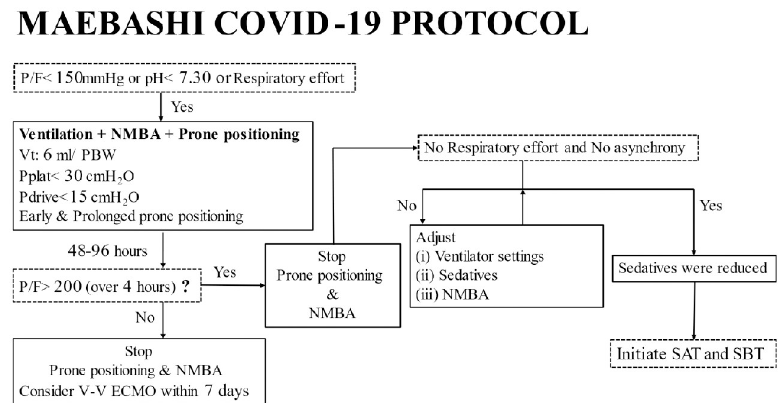
Fig 1. Maebashi COVID-19 protocol. MAEBASHI COVID-19 PROTOCOL (included the lung-protective strategy): Lung-protective ventilation with neuromuscular blocking agents, early application of prone positioning, and prolonged prone positioning. Abbreviations: P/F = PaO2/FIO2; PBW = predicted body weight; Vt = Tidal Volume (mL); Pplat = plateau airway pressure; NMBA = neuromuscular blocking agent; V-V ECMO = veno-venous extracorporeal membrane oxygenation; SAT = spontaneous awakening test; SBT = spontaneous breathing